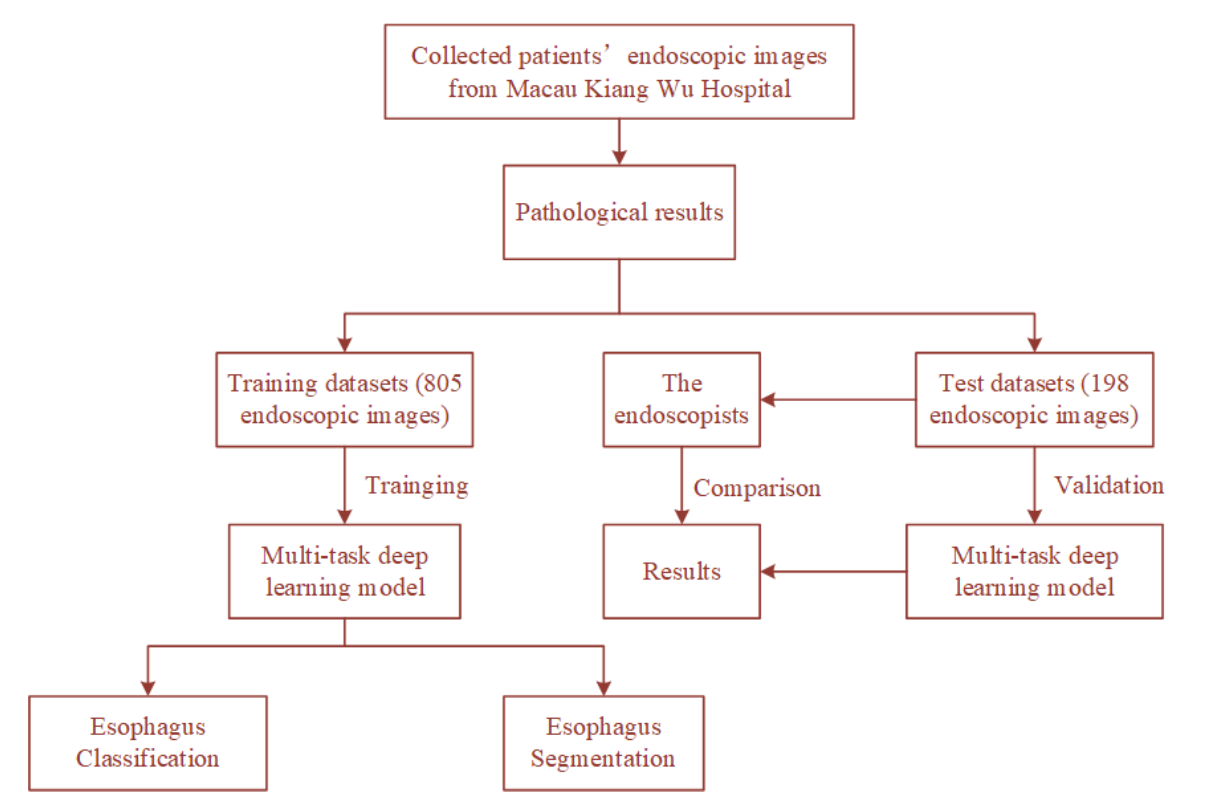
Figure 2. The processes of training and testing the proposed model using the dataset.